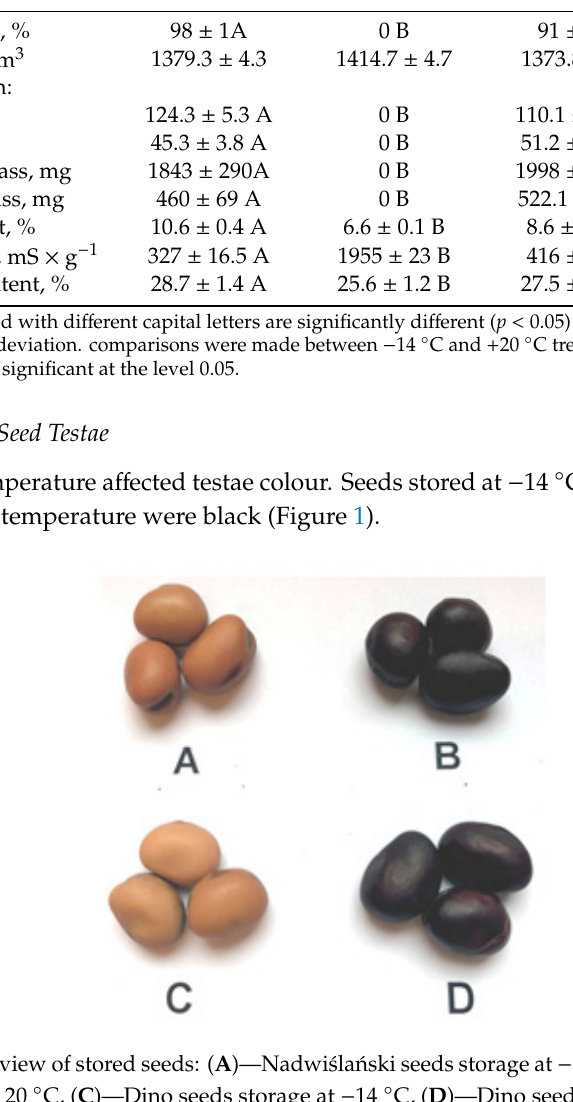
Table 1. Seed viability, radicle and stem length, fresh and dry seedling mass, water content and seed leachate conductivity field bean ( Vicia faba var. minor ) seeds stored for 30 years at − 14 °C and +20 °C.